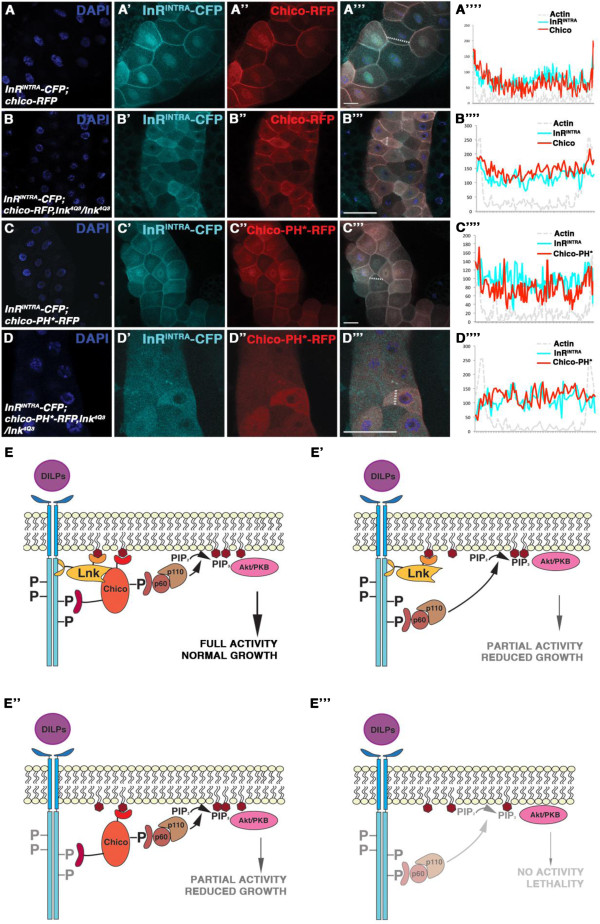
Lnk reinforces membrane localisation of Chico-RFP and InRINTRA-CFP. CFP-tagged InRINTRA is shown in ’ panels, RFP-tagged Chico versions in ” panels. Merged pictures are shown in ”’ panels. Signal intensities measured along the indicated lines in ”’ panels are displayed in ”” panels. Quantifications in Additional file 1: Figure S1C. (A-A””) InRINTRA-CFP (A’) and Chico-RFP (A”) in a wild-type background. (B-B””) InRINTRA-CFP (B’) and Chico-RFP (B”) in lnk4Q3. (C-C””) InRINTRA-CFP (C’) and Chico-PH*-RFP (C”) in wild-type tissue. (D-D””) InRINTRA-CFP (D’) and Chico-PH*-RFP (D”) in lnk−/−. (E-E”’) Model of Lnk function in IIS. In wild-type tissue, Lnk ensures enrichment of InR and Chico at the cortical membrane (E). In the absence of Chico, the p60 subunit of PI3K is able to directly bind to InR (E’). In lnk mutants, despite the reduction of InR at the cellular membrane, Chico is able to bind to residual InR; hence the IIS pathway is partially active (E”). By contrast, when Lnk and Chico are lacking, p60 localisation by the residual InR at the membrane is not sufficient to promote pathway activity (E”’). Number of samples analysed: (A) n=8, (B) n=7, (C) n=7, (D) n = 6. Scale bars represent 50 μm.